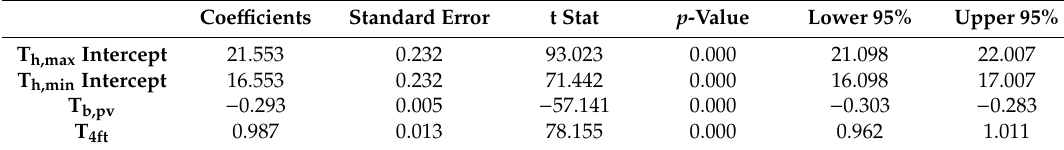
Table 8. Individual t-test on independent variables.